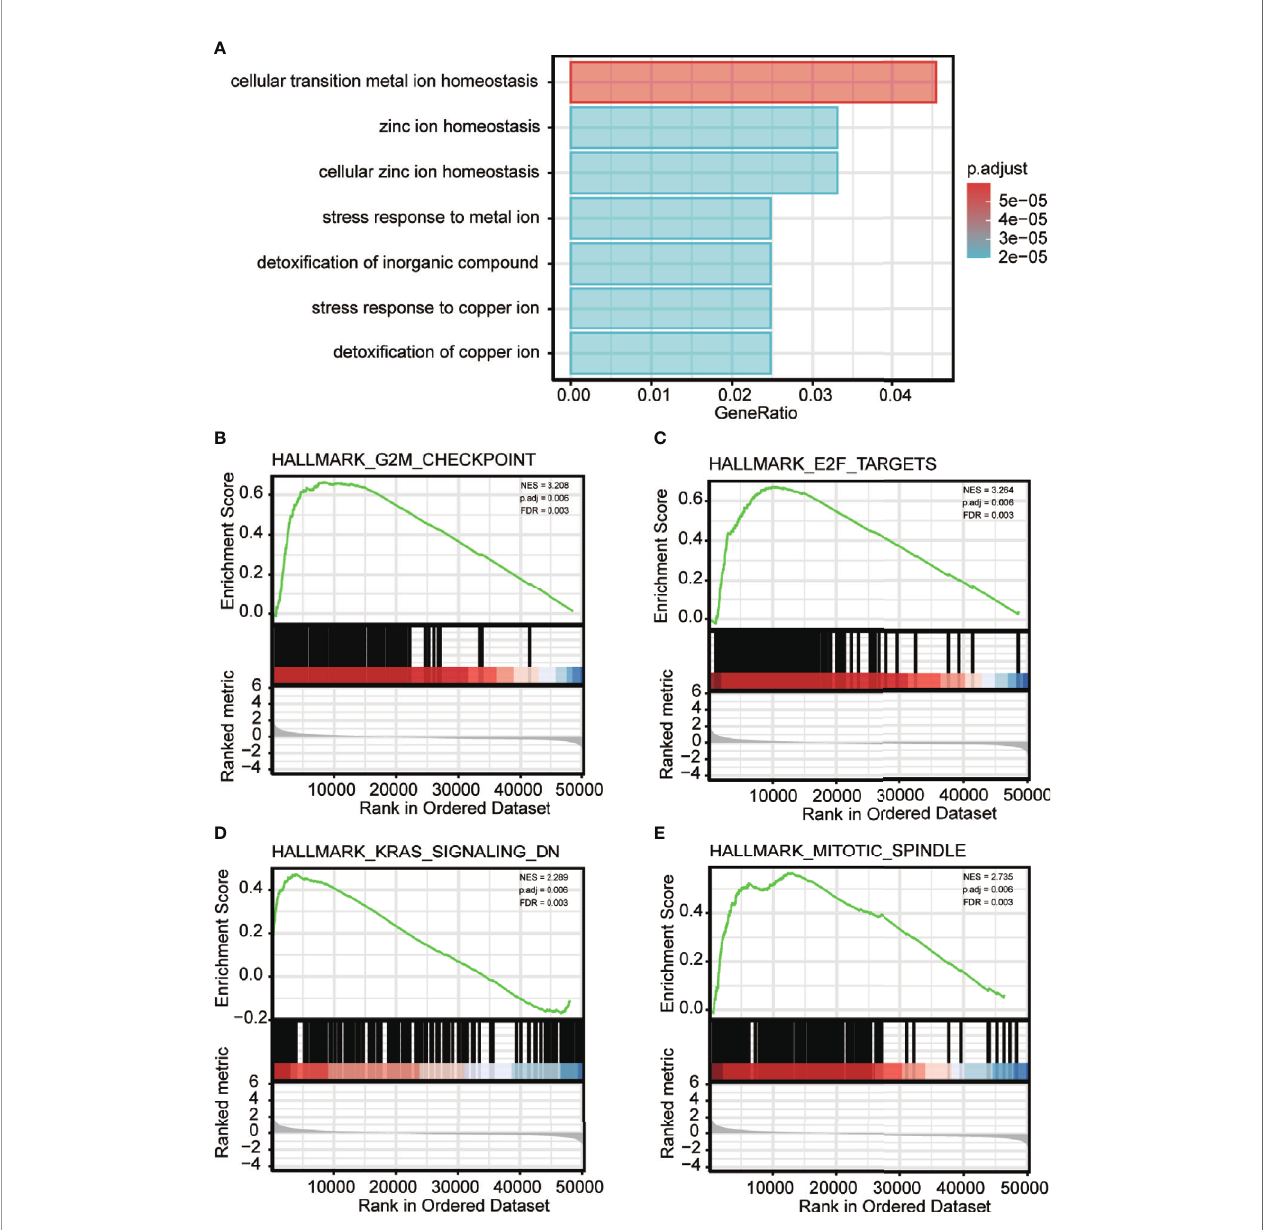
FIGURE 2 | Signi fi cantly enriched GO annotations of METTL18 related genes in HCC. (A) Top seven of biological process enrichment related to METTL18 related genes with bar graph. (B – E) Enrichment plots from the gene set enrichment analysis (GSEA). Several pathways and biological processes were differentially enriched in METTL18-related HCC, including G2M checkpoint, KRAS signaling, mitotic spindle and E2F targets. NES, normalized enrichment score; p. adj, adjusted P value; FDR, false discovery